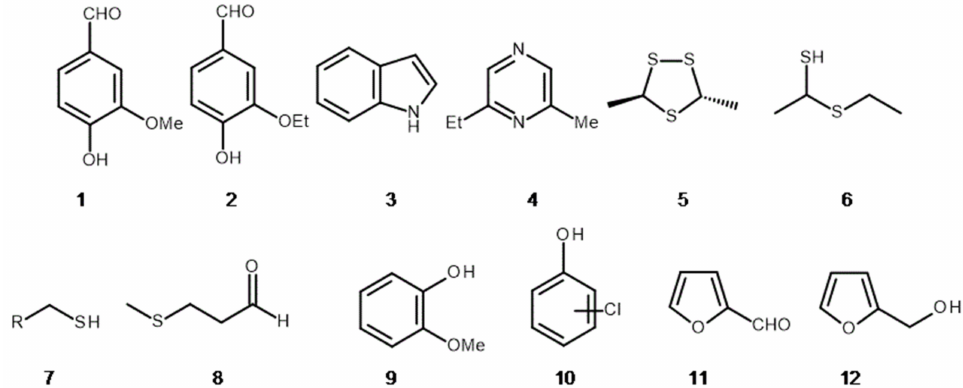
Figure 2. Some food occurring compounds with strong aroma: ( 1 ) Vanillin, ( 2 ) ethylvanillin, ( 3 ) indole, ( 4 ) 2-ethylpyrazine- 6-methylpyrazine, ( 5 ) ( E )-3,5-dimethyl-1,2,4-trithiolane, ( 6 ) 1-(ethylsulphanyl)ethane-1-thiol, ( 7 ) R=Me, ethanethiol, ( 8 ) me- thional, ( 9 ) guaiacol, ( 10 ) halophenols, ( 11 ) furfural and ( 12 )